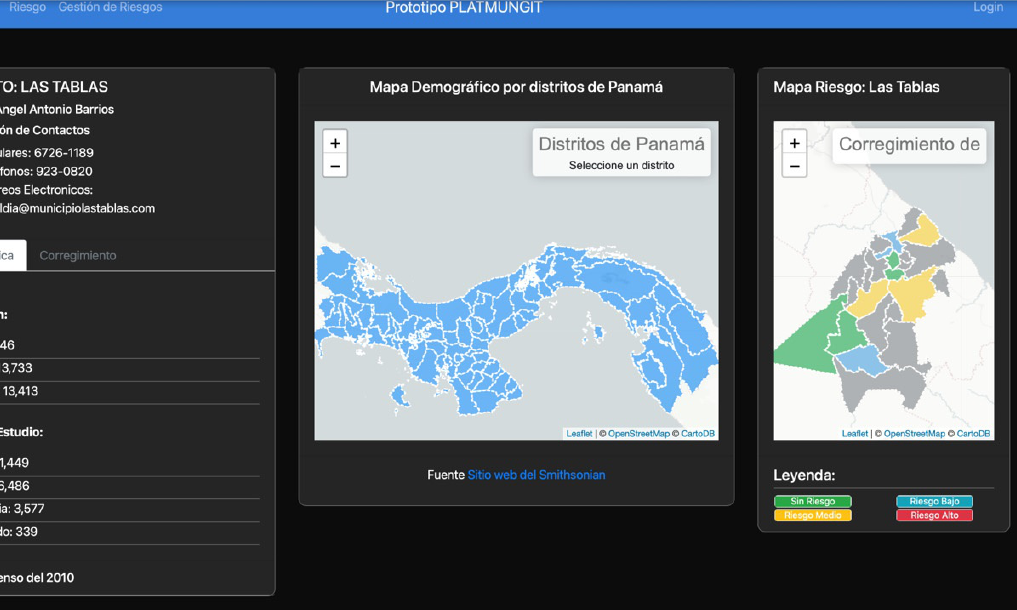
Figure 9. Bar Graph based on municipalities with their risk levels. This project strengthens the government sector, in this case community or district, in risk management using information and communication technology to facilitate decision- making using a risk indicator by district. 5. Model Discussion In this article, three prototypes of systems have been presented that have as an inno- vative aspect the inclusion of people with visual and hearing disabilities to assist them in the different areas described. Each one presents its main characteristics, the beneficiaries, the impact on the community, its limitations, and its ability to scale, which represents a great potential for use and assistance for people with disabilities, among others, if they were integrated or merged. However, this aspect of integration of the systems presented in this article has a high potential for feasibility and is achievable, because some research